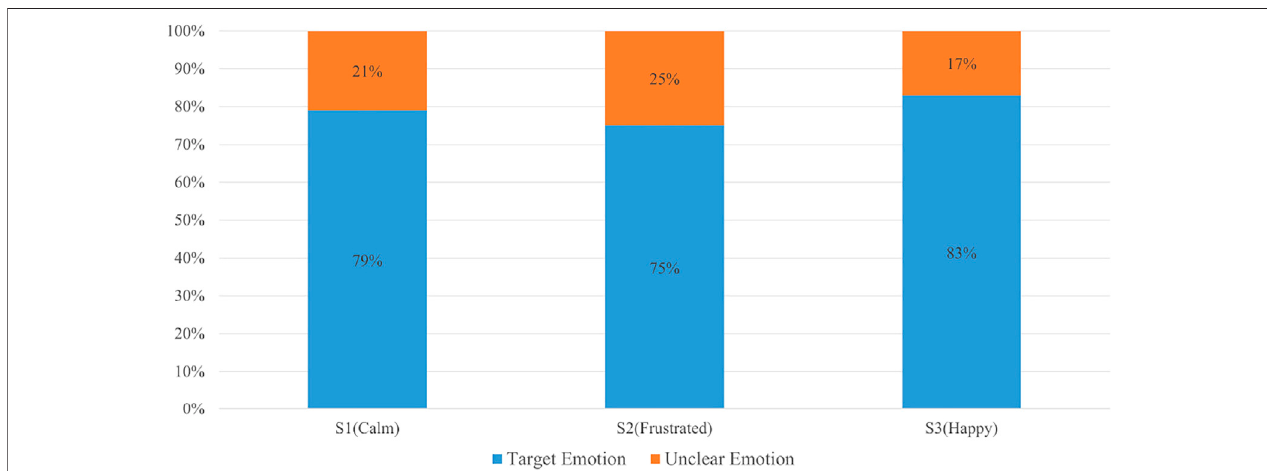
FIGURE 5 | The distribution of the targeted emotions across all subjects and events.